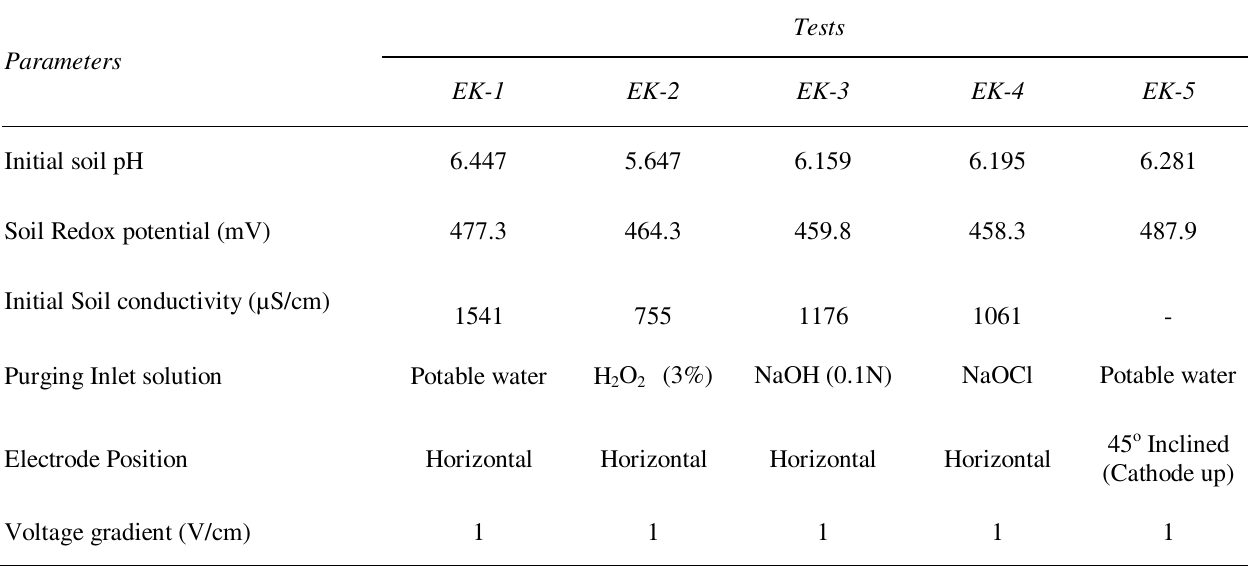
Table 1: Summary of Experimental